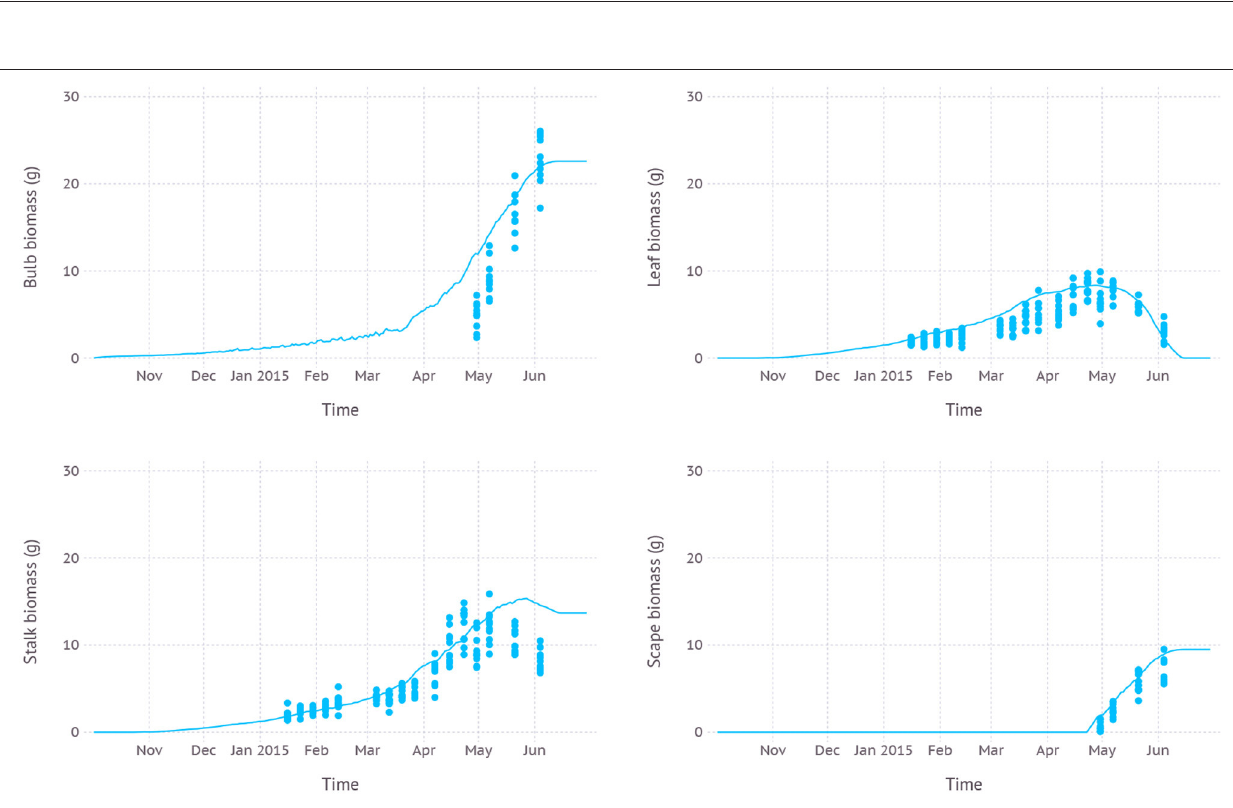
Frontiers in Plant Science |